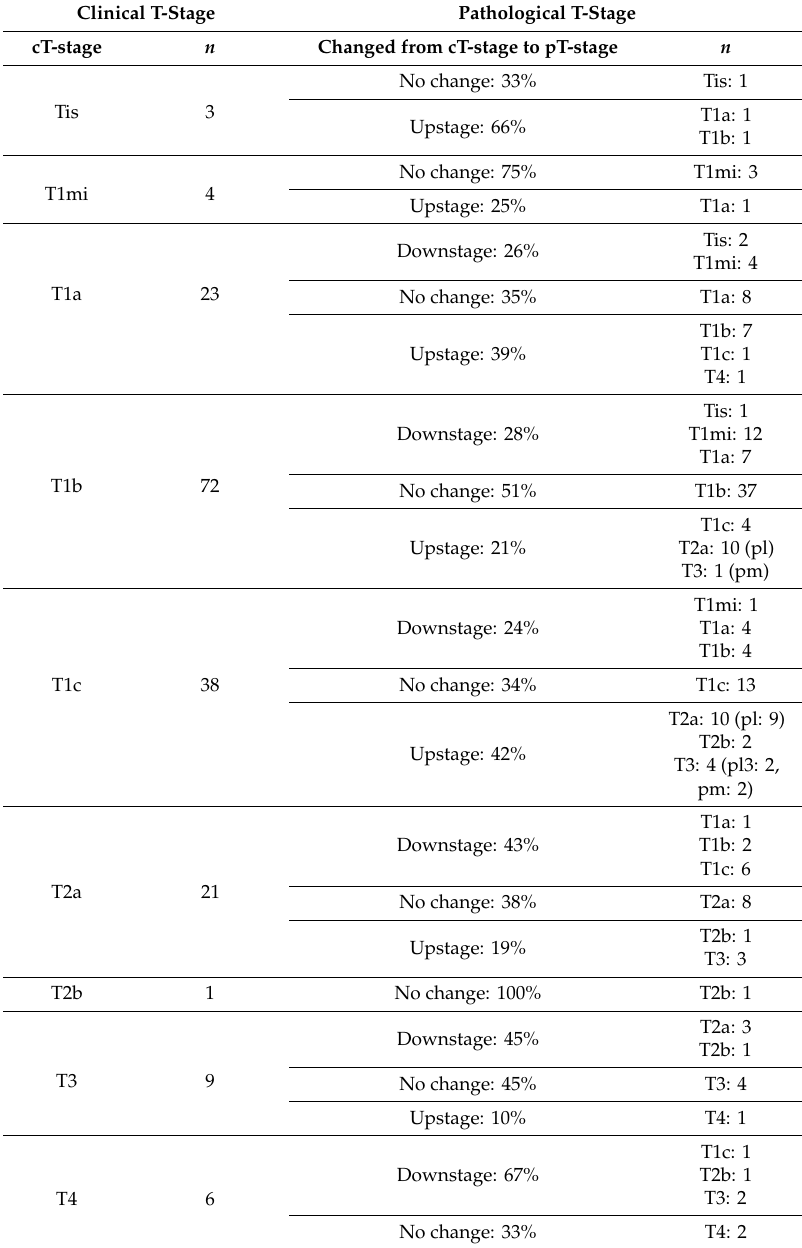
Table 3. Number of cases changed from clinical T-stage to pathological